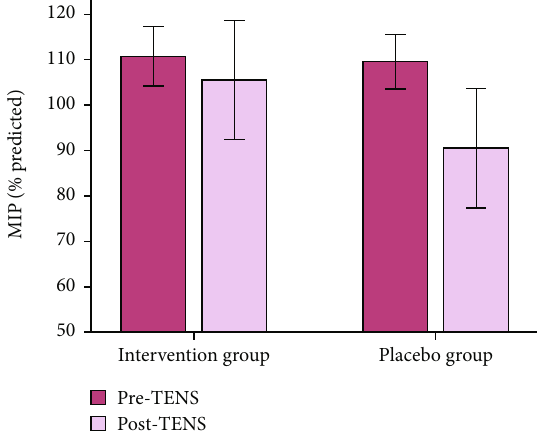
Figure 1: Comparisons in maximum inspiratory pressure (MIP) measurements before (pre-TENS) and after (post-TENS) electroanalgesia sessions (absolute delta) between the intervention and placebo group ( p = 0 : 03